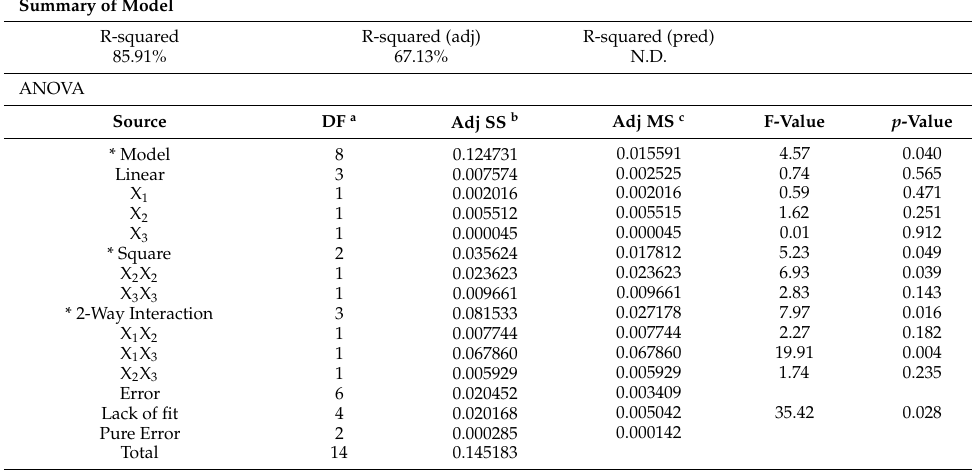
Table 4. A summary from response surface regression